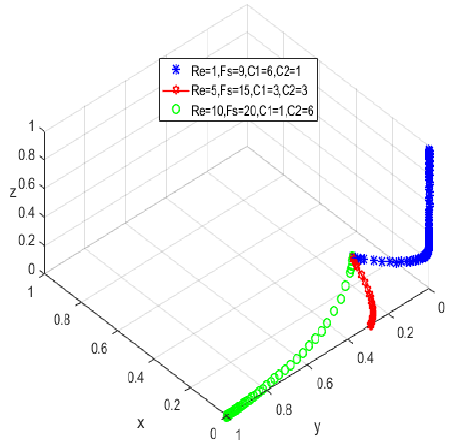
Figure 9. Trend graph for R e , F s , C 2 , and C 1 .